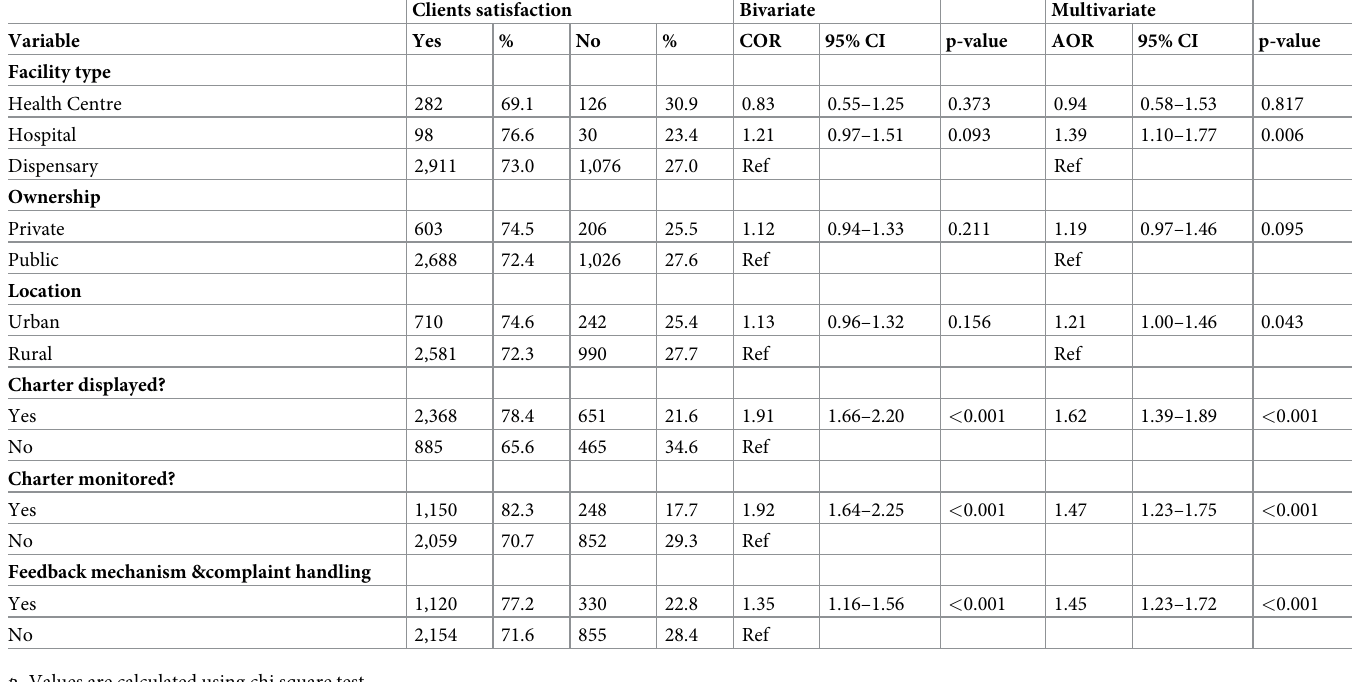
Table 5. Predictors of clients’ satisfaction at primary healthcare facilities during SRA of 2017/18. Clients